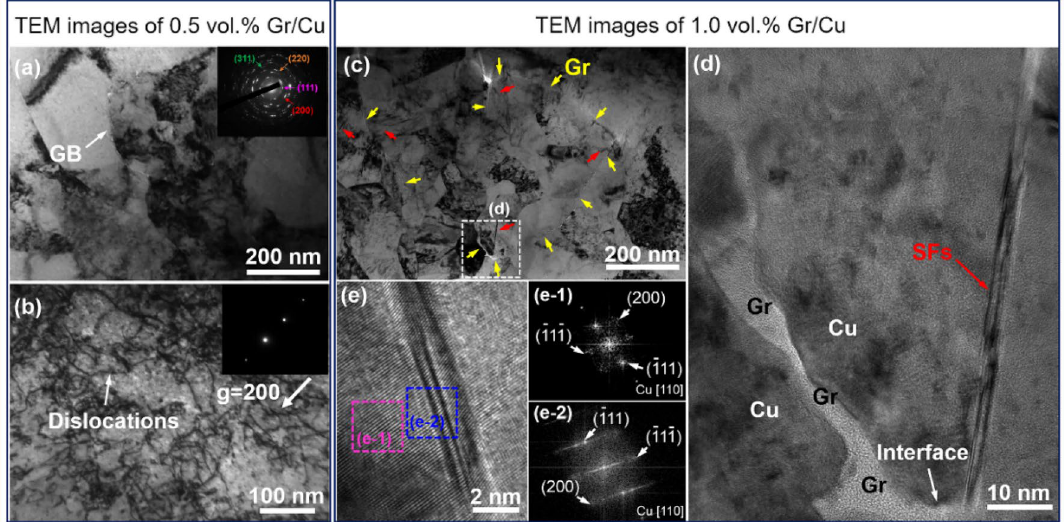
Figure 8. The TEM images of the Gr/Cu composites with different contents of Gr. ( a , b ) For the 0.5 vol.% Gr/Cu composites, the thermal mismatch dislocations are observed under two-beam condition with the g vector (200) of Cu. ( c – e ) For the 1.0 vol.% Gr/Cu composites, the interfacial thermal mismatch defect type transforms from dislocations to nanotwins, which are identified by the SAED patterns in e-1 and